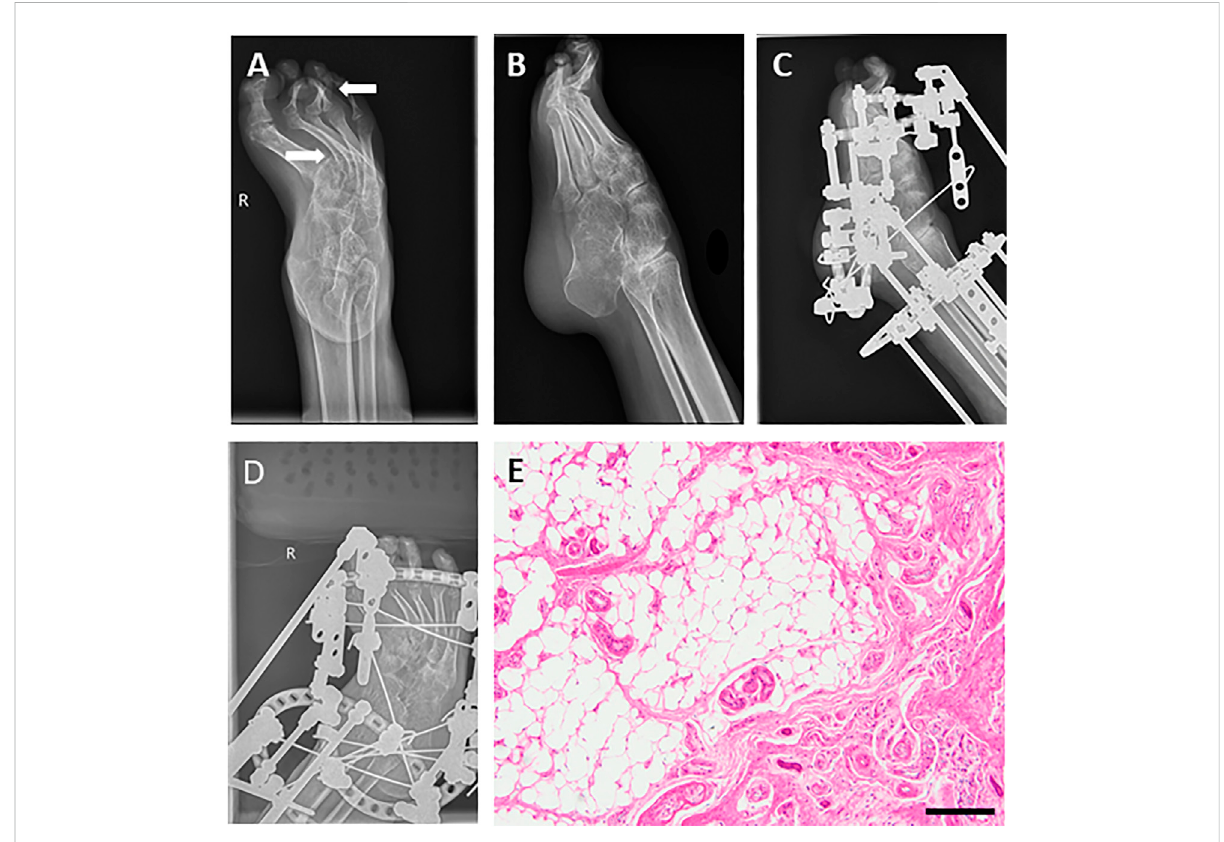
FIGURE 2 Images before and after orthopedics for equinovarus deformity ofthe right foot. (A,B) Foot drop and equinovarus deformity on DR (right). (C,D) Images after orthopedics of equinovarus deformity (right). (E) Pathological section of the fourth toe of the right foot showed chronic mucosal in fl ammation with submucosal fi brous adipose tissue hyperplasia and a little cortical bone tissue. Bar = 200 μ